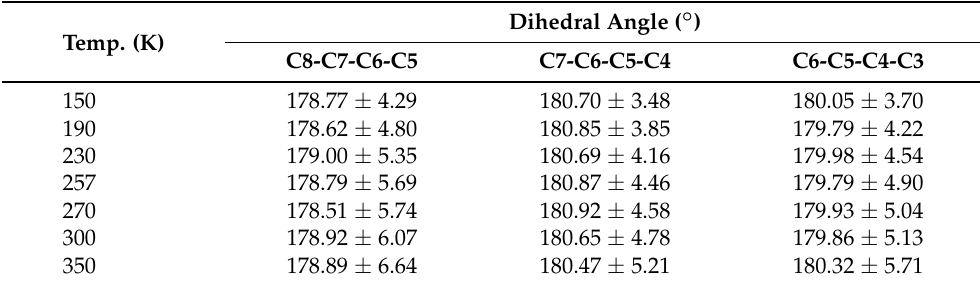
Table 2. Temperature dependence of the indicated dihedral angles: arithmetic mean ± standard deviation along the trajectory. Results of Car–Parrinello MD